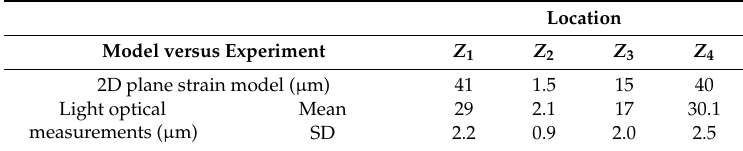
Table 5. Heat treatment-induced gaps at room temperature, simulation results, and optical measurements. Mean and standard deviation (SD) are shown